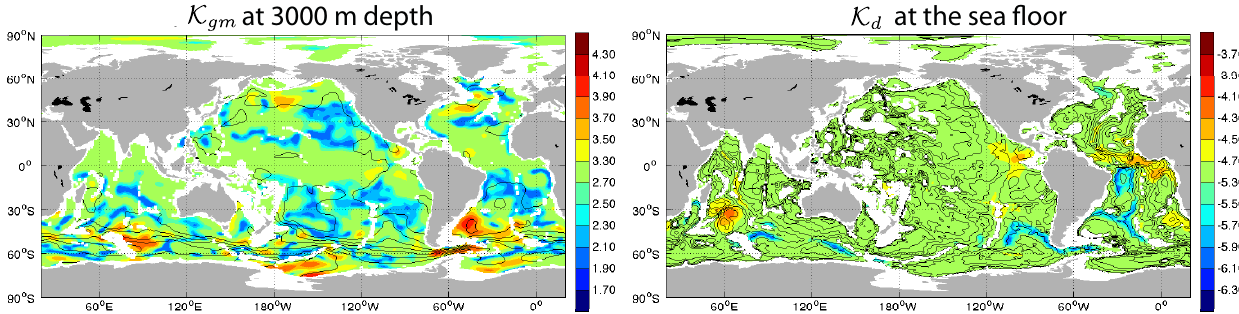
Figure 12. Estimated bolus velocity coefficient at 3000m depth (left) and diapycnal diffusivity immediately above the sea floor (right) in square meters per second (log 10 color scale). Overlaid contours: σ 1 potential density from the OCCA atlas in 0.02kgm − 3 increments (left) and ocean depth in 500m increments